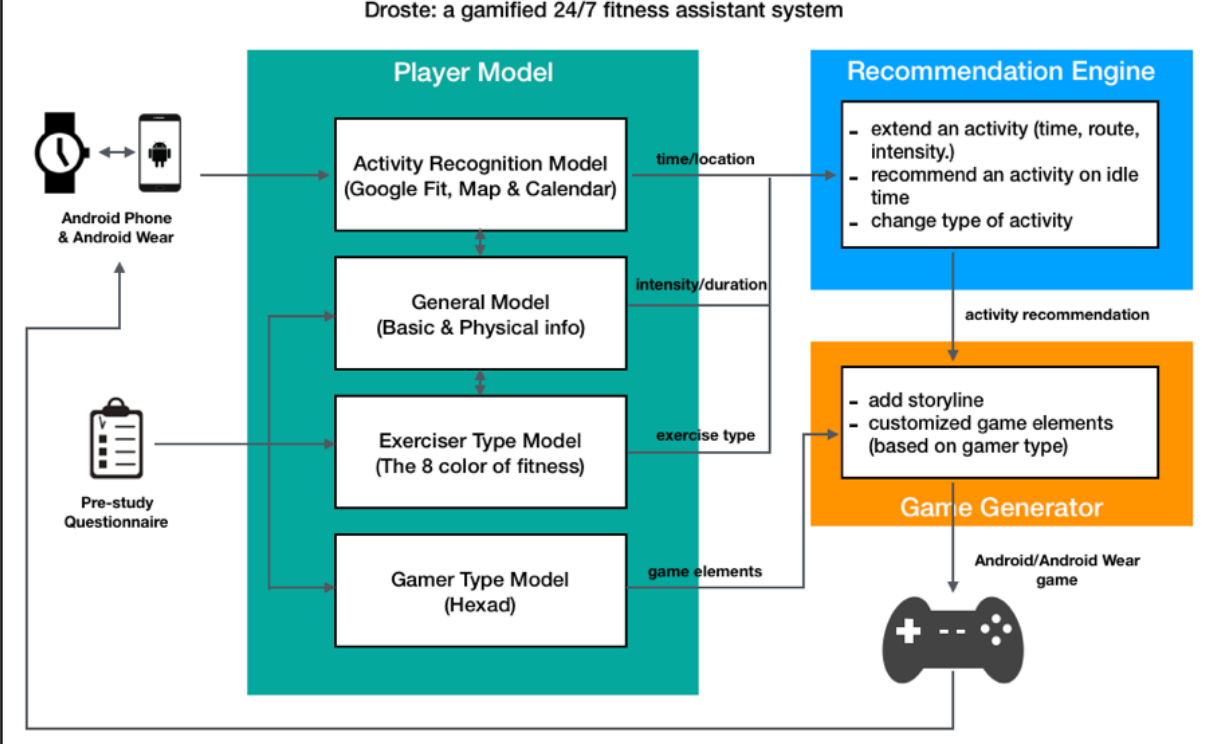
Figure 2. App architecture. How data were collected and transferred to each submodel of the system and how they were used to generate recommendations and game content. Info: information.